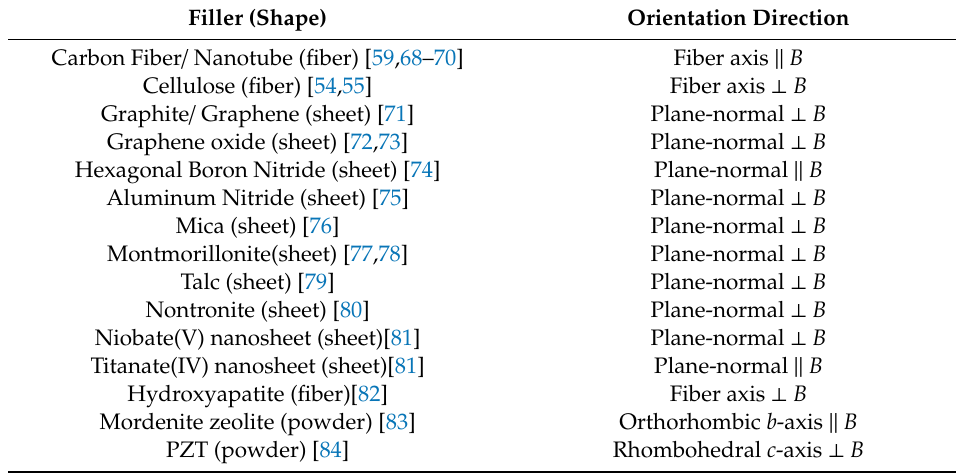
Table 1. List of magnetically aligned fillers. Orientation direction shows the relationship with a static magnetic